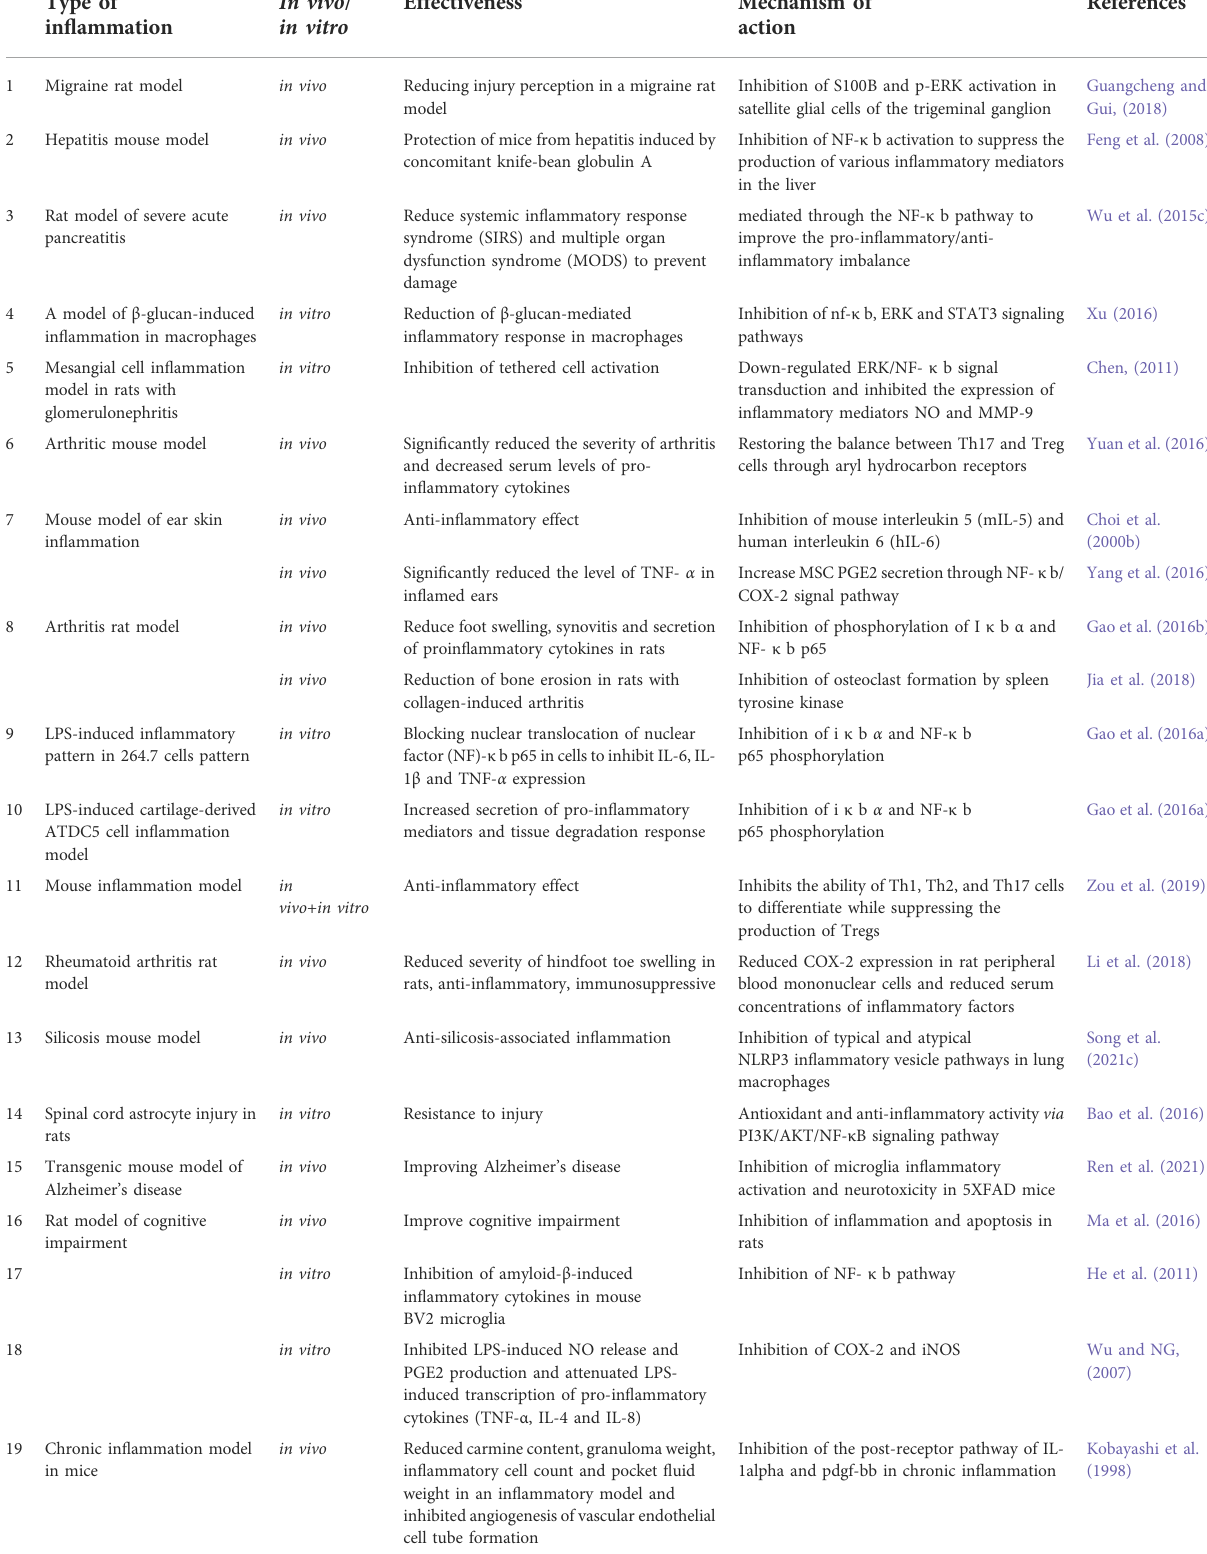
TABLE 2 Tet anti-in fl ammatory effect and mechanism of